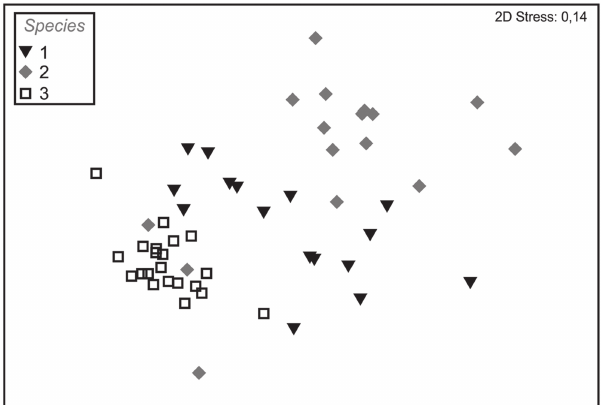
Fig. 4 . Non-metric multidimensional scaling plots (nMDS) coded by habitat for Diapterus rhombeus , Eucinostomus melanopterus and Eugerres brasilianus in the rio Mamanguape estuary, Brazil. Filled symbols (gray= D. rhombeus and black= E. melanopterus ) and open symbols ( E. brasilianus